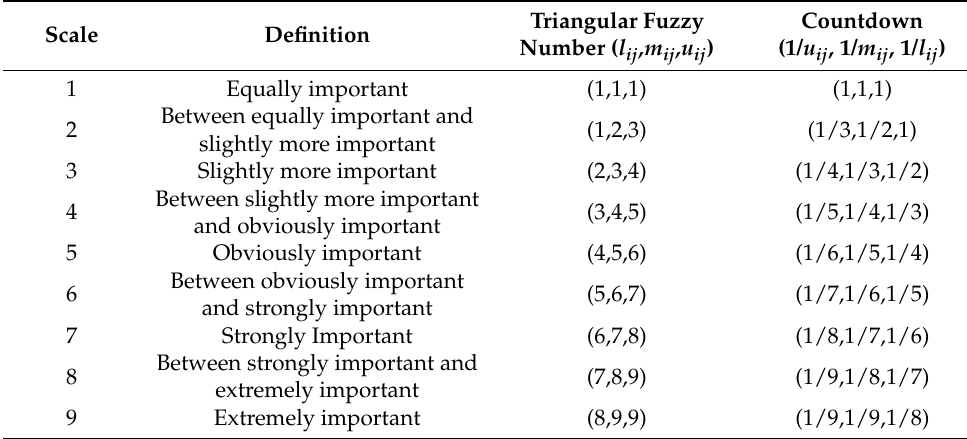
Table 1. Nine-level fuzzy scale of expert judgment